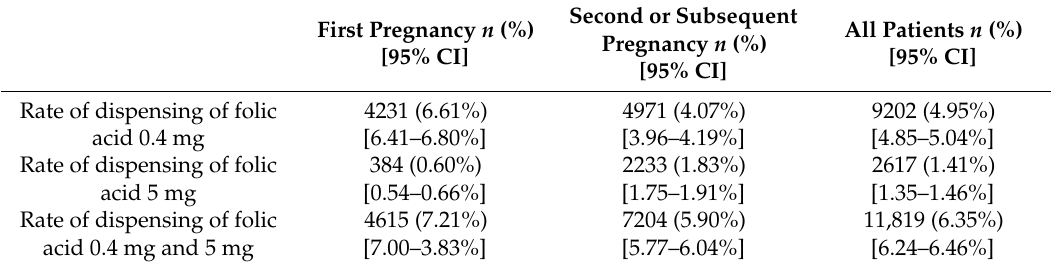
Table 1. Rate of preconceptional dispensing of folic acid from 2006 to 2016, in 186,061 pregnancies.